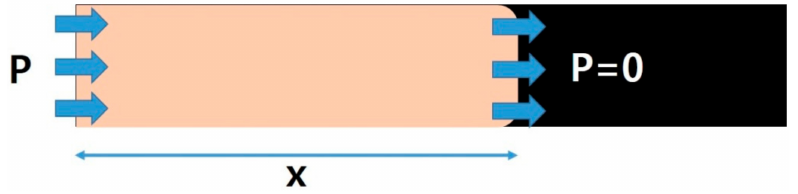
Figure 15. Illustration of porous media flow.